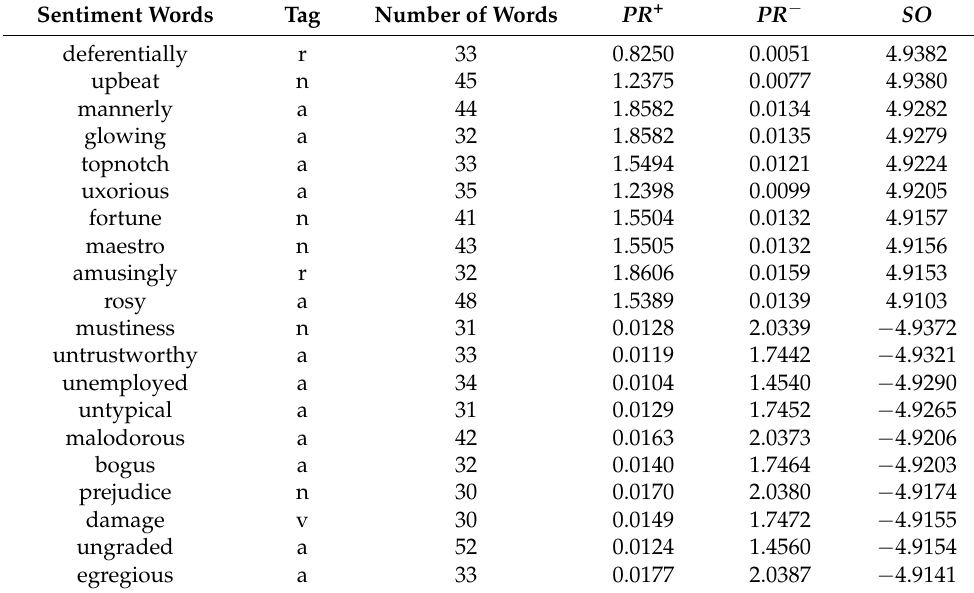
Table 6. TOP 10 positive and negative sentiment